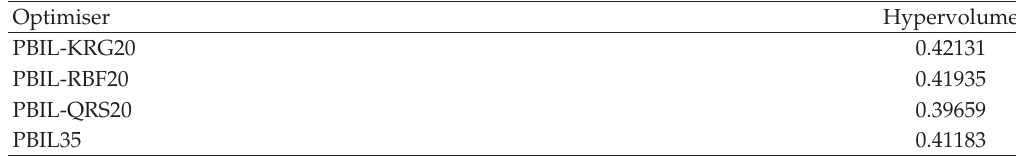
Table 1: Hypervolume comparison (cid:2) reference point is (cid:5) 303, 0.1 (cid:6)(cid:3) .